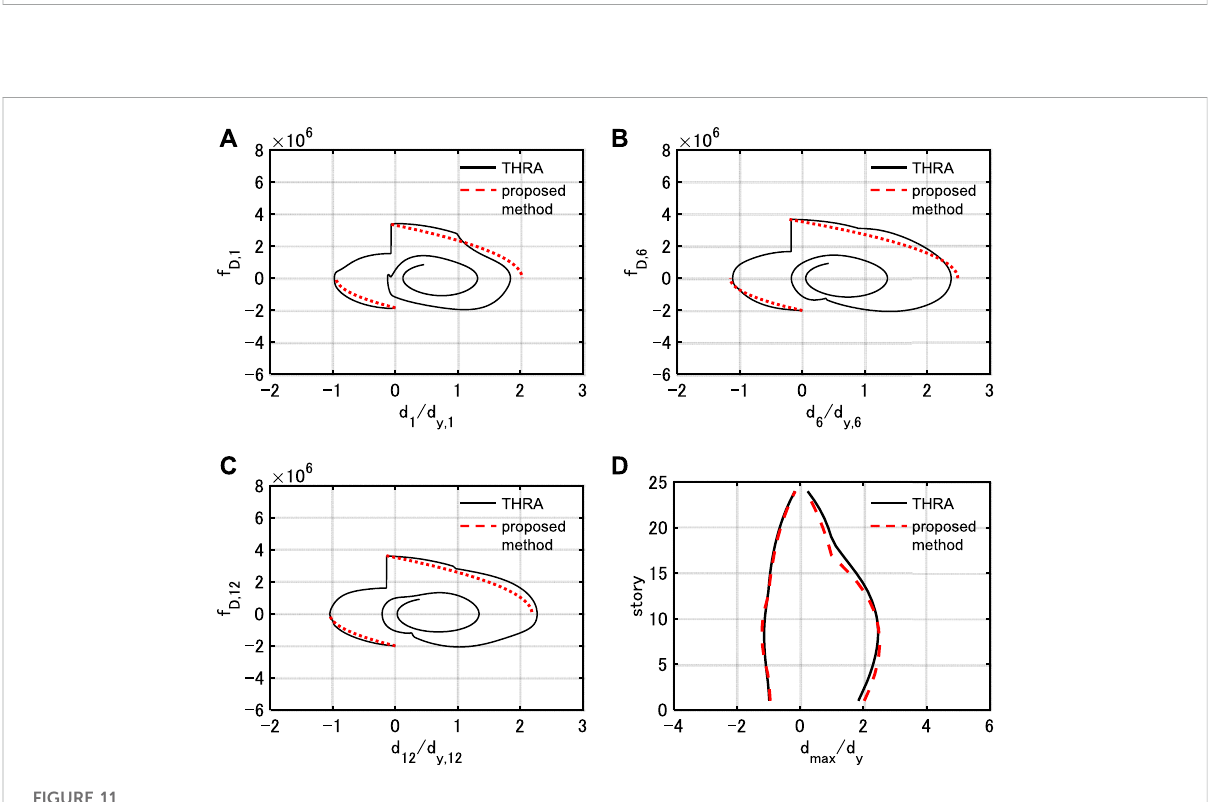
FIGURE 11 Damping force-interstory drift relation under PDI with V (cid:1) 1 . 2m / s (Model 1) by time-history response analysis and proposed method, (A) 1st story, (B) 6th story, (C) 12th story, (D) maximum interstory